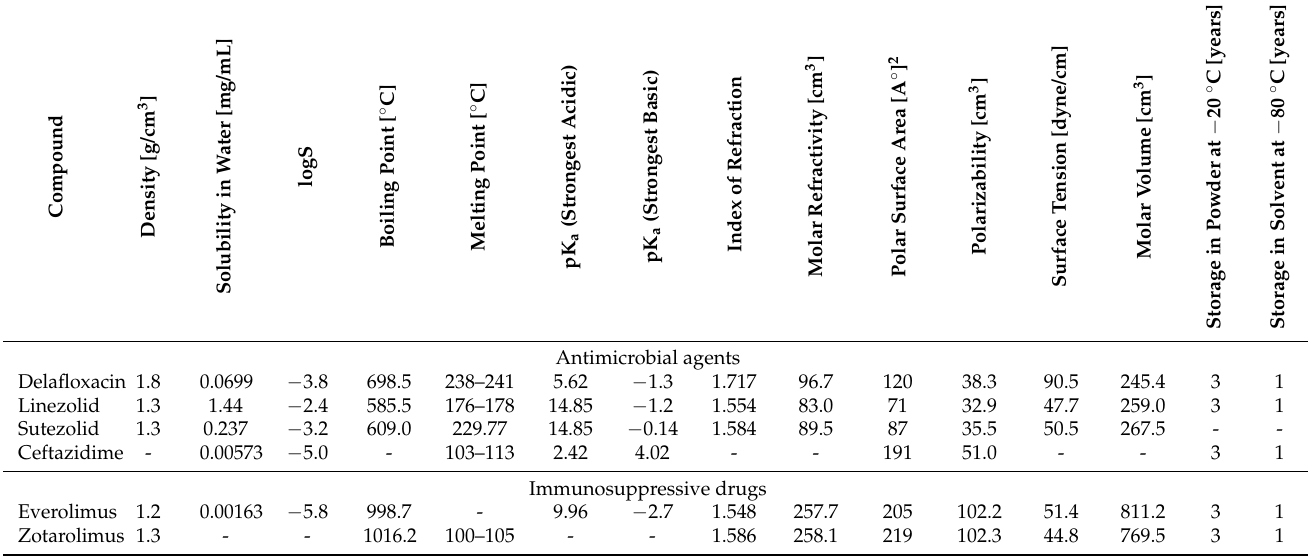
Table 1. Physicochemical parameters of tested